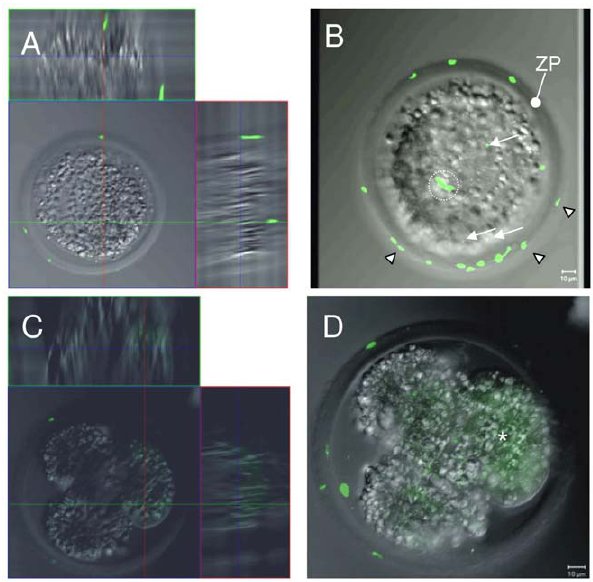
Figure 4. Venus fluorophore transmission to zygotes. Venus fluorescence was analysed in fertilized zygotes to 4-cell stages by confocal microscopy, and overlays of DIC and Venus channels are shown. A): Single optical section of 2 micrometer thickness from the equatorial region of a zygote, together with the orthogonal xz and yz views. B) Corresponding projection of a series of optical planes. This zygote contains three discrete Venus fluorescent spots inside the cytoplasm (arrows), but not in the pronuclei. Most likely, these reflect remnants of postacrosomal sheath and mid piece of one spermatozoon. Note, the intensive fluorescence of spermatozoa at the outside of the zygote, attached to the Zona pellucida (ZP) (some are marked with white triangle). Due to the projection, spermatozoa, which are attached to the top or the bottom appear seemingly to be inside the zygote (dashed circle). However, an analysis of the individual optical sections allows an unequivocal determination of their position. C) Single optical section of 2 micrometer thickness of a 4-cell stage, together with the orthogonal xz and yz views. D) Corresponding projection of optical planes. Asterisk indicates blastomere with de novo synthesized Venus protein.